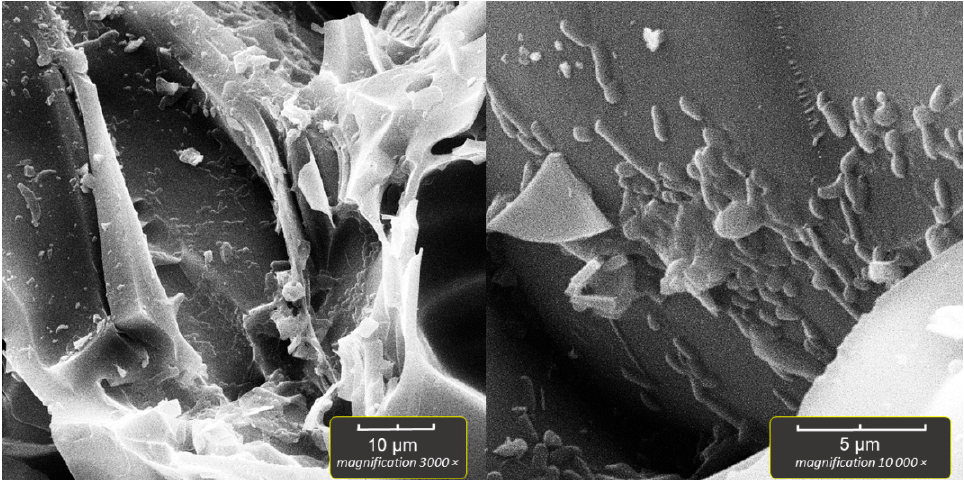
Figure 5. SEM image of bacteria immobilized on perlite in an experimental setup with aeration and Olive Cake (OC) consortium.